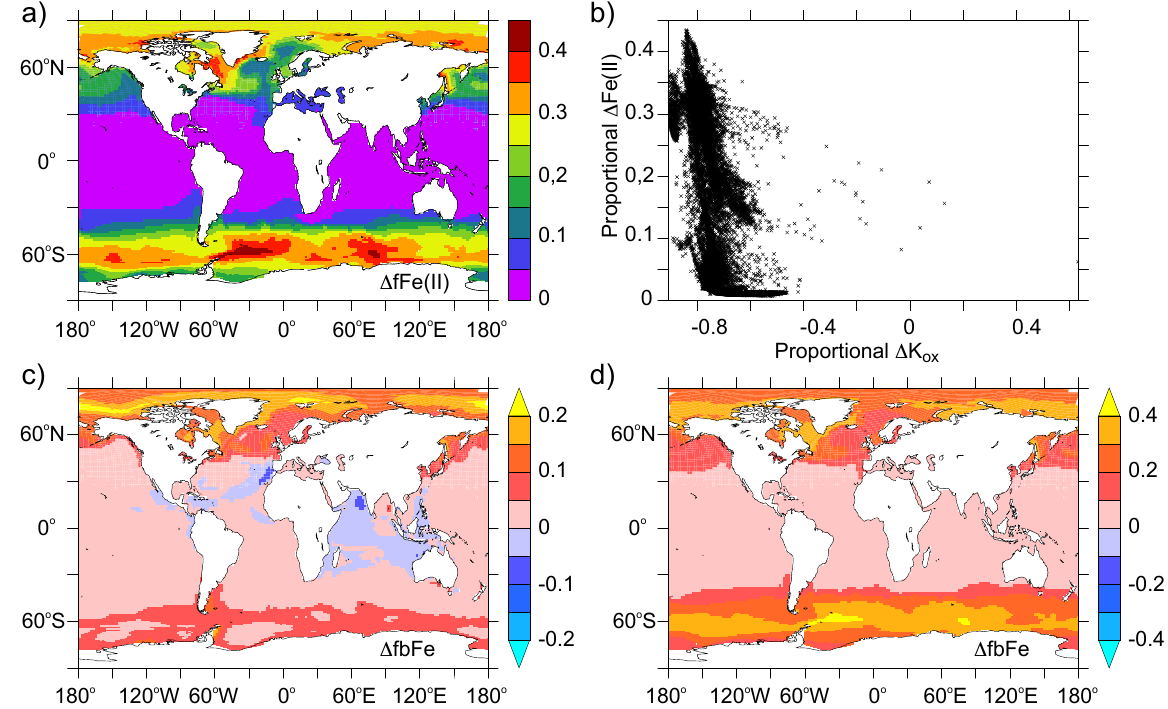
) /X low CO ) change in the (a) proportion of the dFe pool present as Fe(II) at an Fig. 9. The proportional (i.e., (X high CO – X low CO 2 2 2 atmospheric CO 2 level of ∼ 1000ppm and (b) its relationship to the proportional change in the oxidation rate constant, and the proportional change in the proportion of the dFe pool present as bFe pool when bFe equals (c) Fe(II) + Fe(III) + FeL S and (d) Fe(II) +